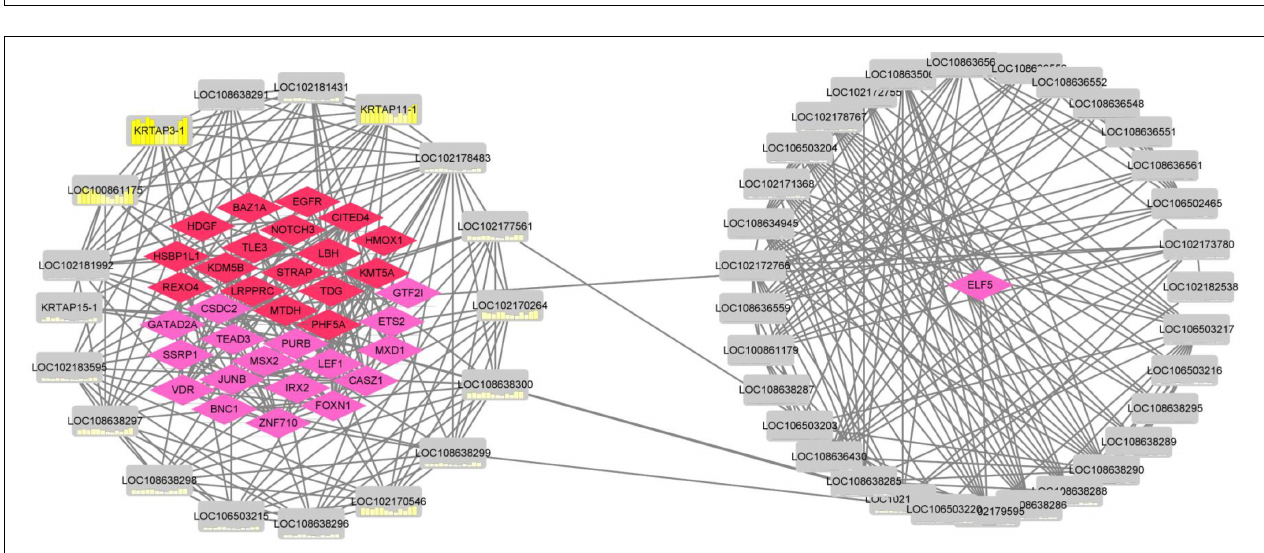
FIGURE 7 | Heat map of the number of ASE loci in the 1M region. (A) Quantitative heat map of ASE loci in every 1M region of chromosome 19. (B) A total of 308 regions exhibiting differences in the proportion of ASE sites between the control and treatment groups (minimum/maximum ≤ 0.3), and the locations at which ASE numbers differed between months. The number represents the month, c represents the control group, t represents the treatment group.